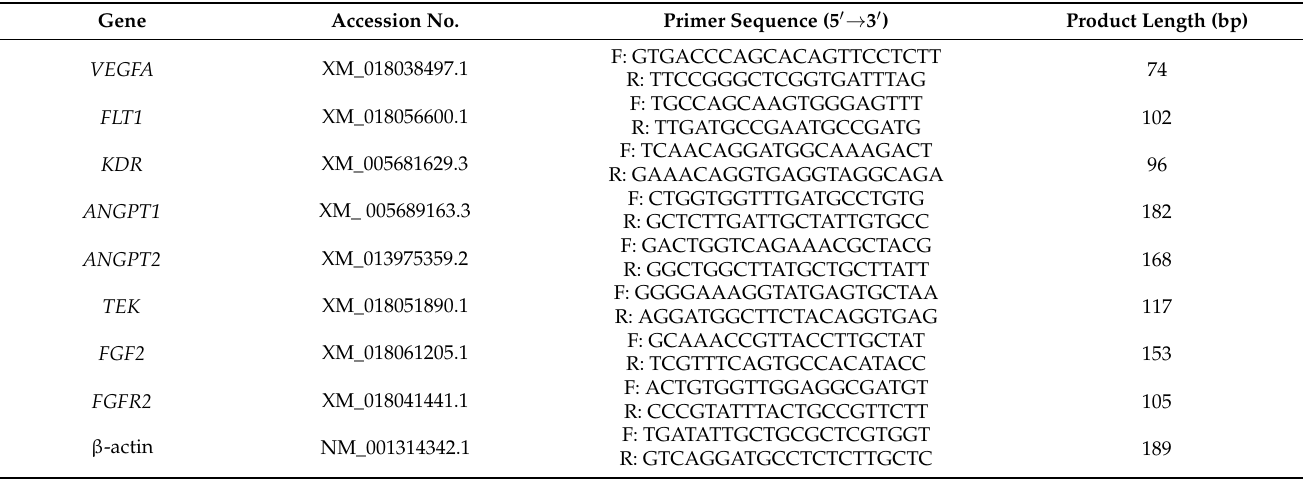
Table 1. The information of primer sequence